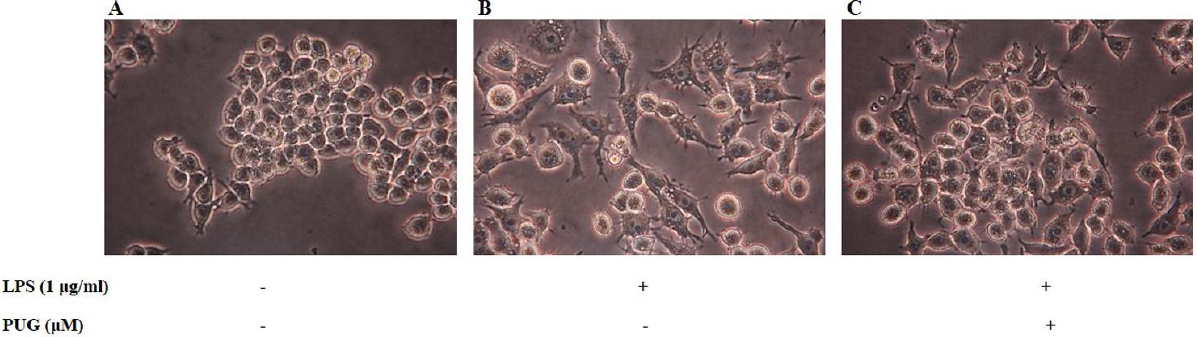
Figure 2. Morphological changes induced by PUG in RAW264.7 cells: Cells were grown in DMEM media at 37 °C in a humidified environment with 5% CO 2 . After attaining the desired growth, the cells were seeded at 5 × 10 4 cells/plate. Then, LPS (1 μg/mL) treatment for 1 h, followed by PUG (6 µ M) treatment for 24 h were given. After treatment, plates were observed under an inverted microscope. ( A ) Control cells. ( B ) LPS-stimulated cells. ( C ) LPS + PUG (6 µ M) co-treated